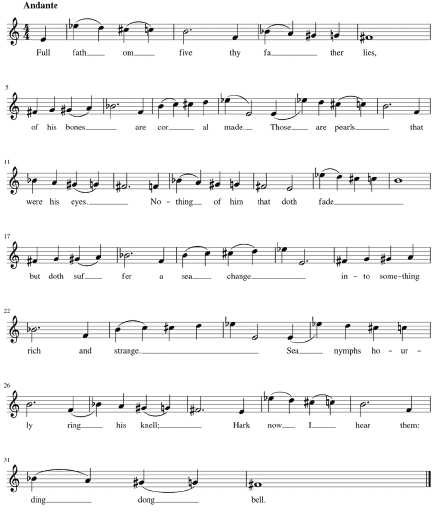
Figure 1. Samples of notations from